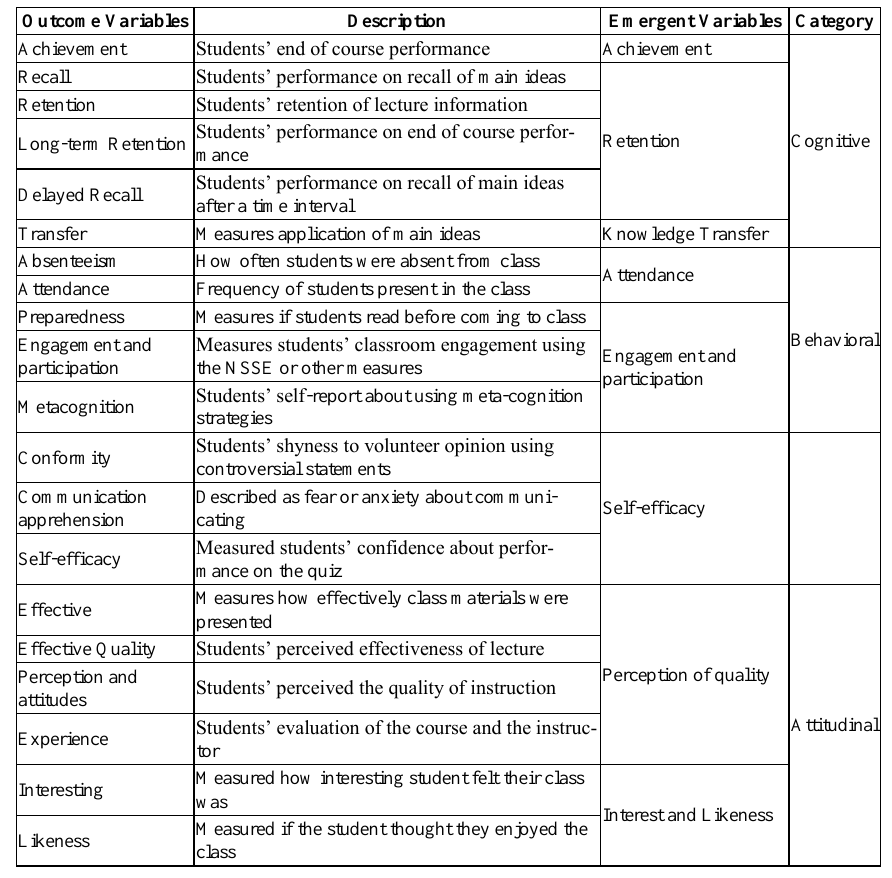
Table 1. Educational learning outcome